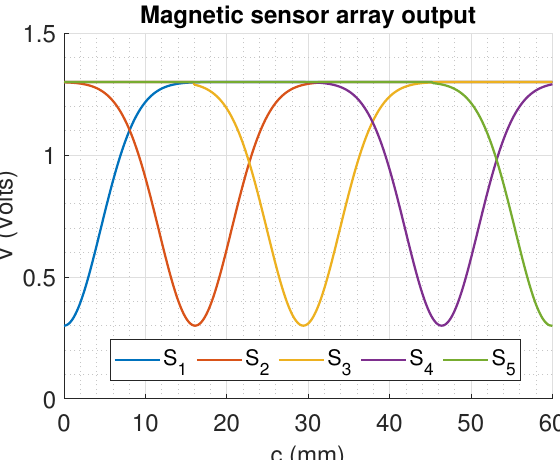
Figure 9. Ideal output from the magnetic sensor array, considering that all the actuators have been placed such that the sensing range between them